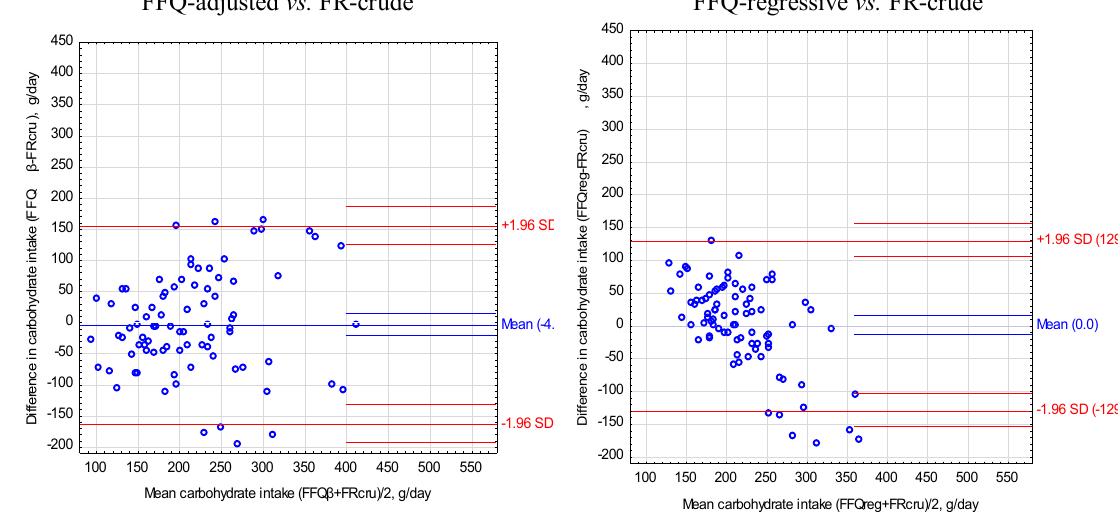
Figure 3. Cont. FFQ-adjusted vs. FR-crude FFQ-regressive vs.